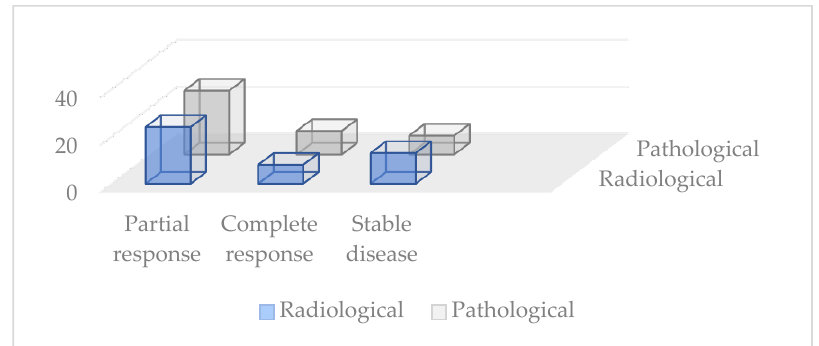
Figure 2. Comparation between pathological and radiological response.